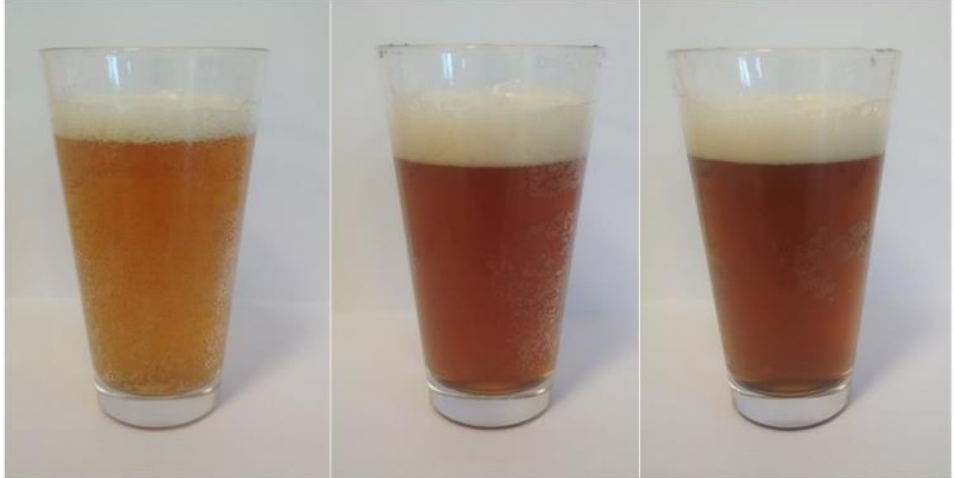
Figure 1. The appearance of the obtained barley beers with addition of the Saskatoon fruits; from